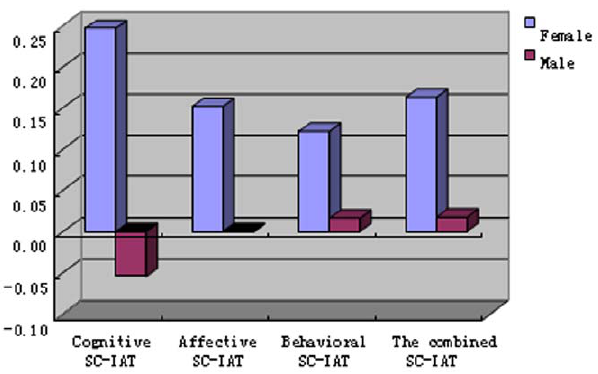
Figure 1. Gender differences in implicit stigma toward mental